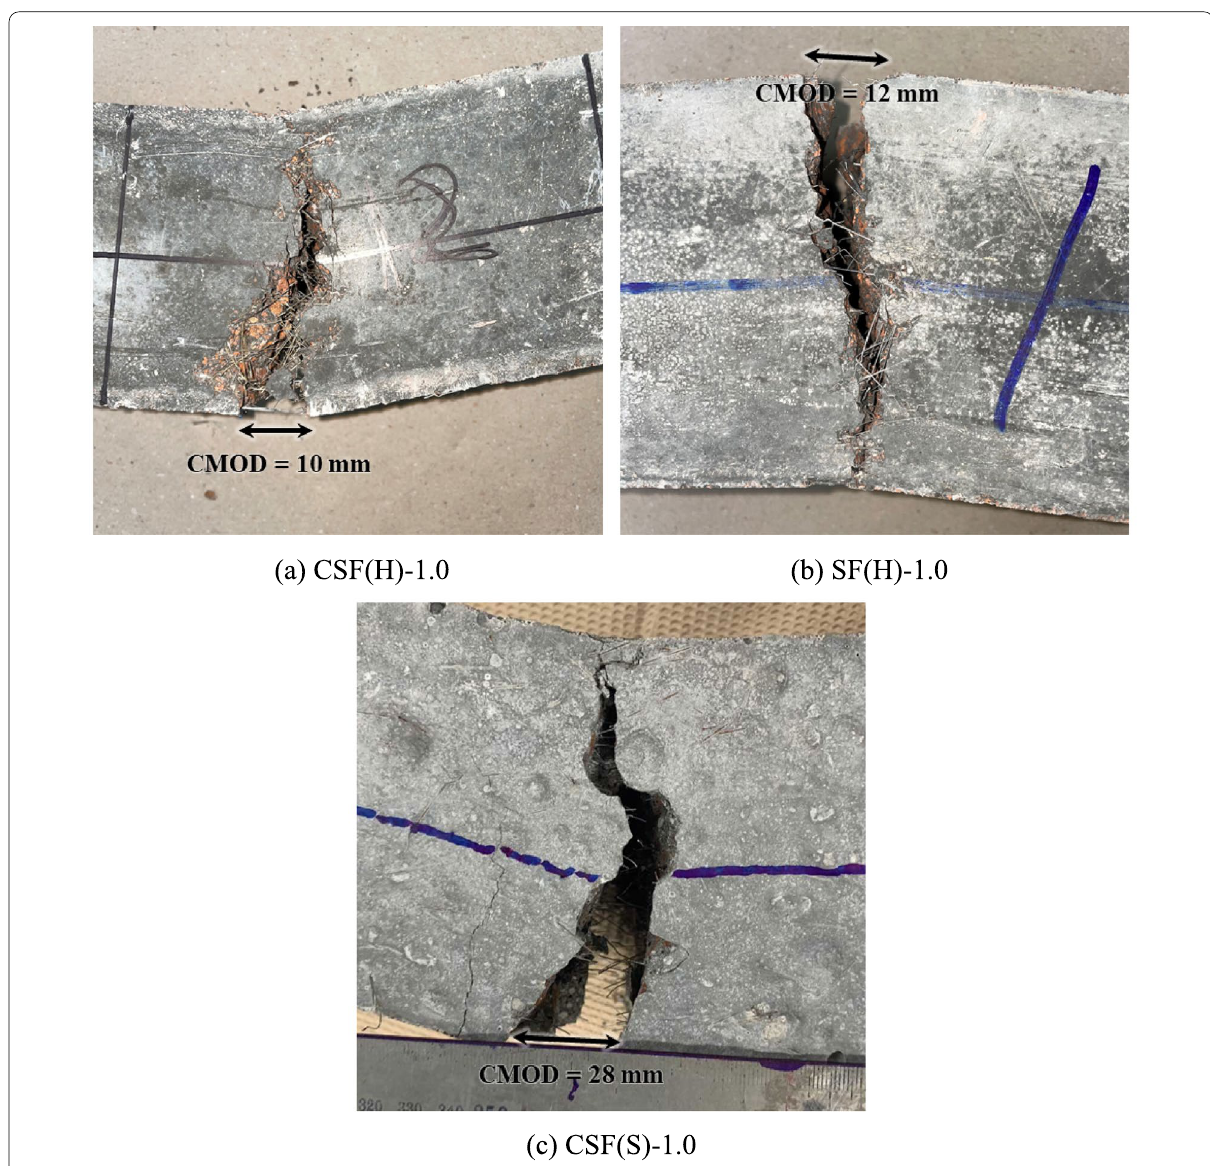
Fig. 10 Typical images of crack pattern after four‑point bending test: a CSF(H)‑1.0; b SF(H)‑1.0; c